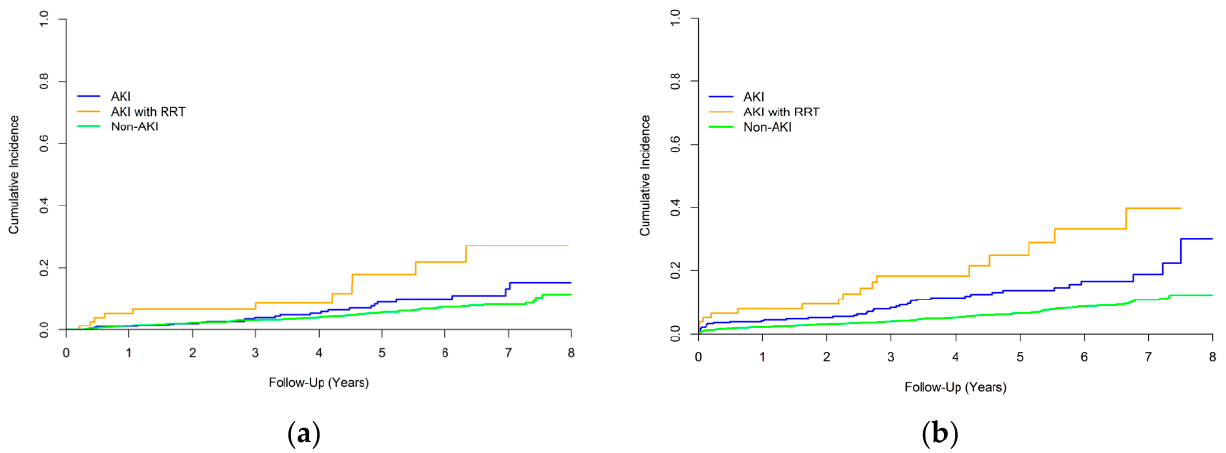
Figure 4. Unadjusted cumulative event rates of ( a ) mortality and ( b ) new-onset CKD in each study group.